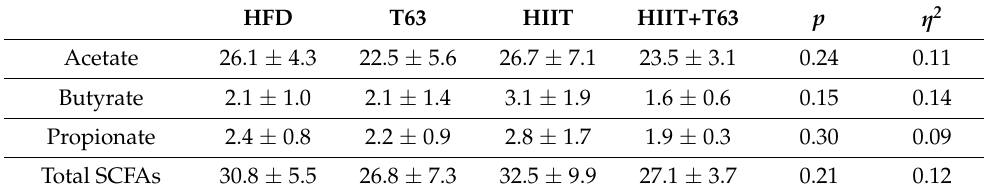
Table 3. Fecal acetate, butyrate and propionate concentration ( µ mol · g − 1 feces) at the end of interven- tion period. SCFAs, Short chain fatty acids; Total SCFAs = acetate + butyrate + propionate. HFD T63 HIIT HIIT+T63 p η 2